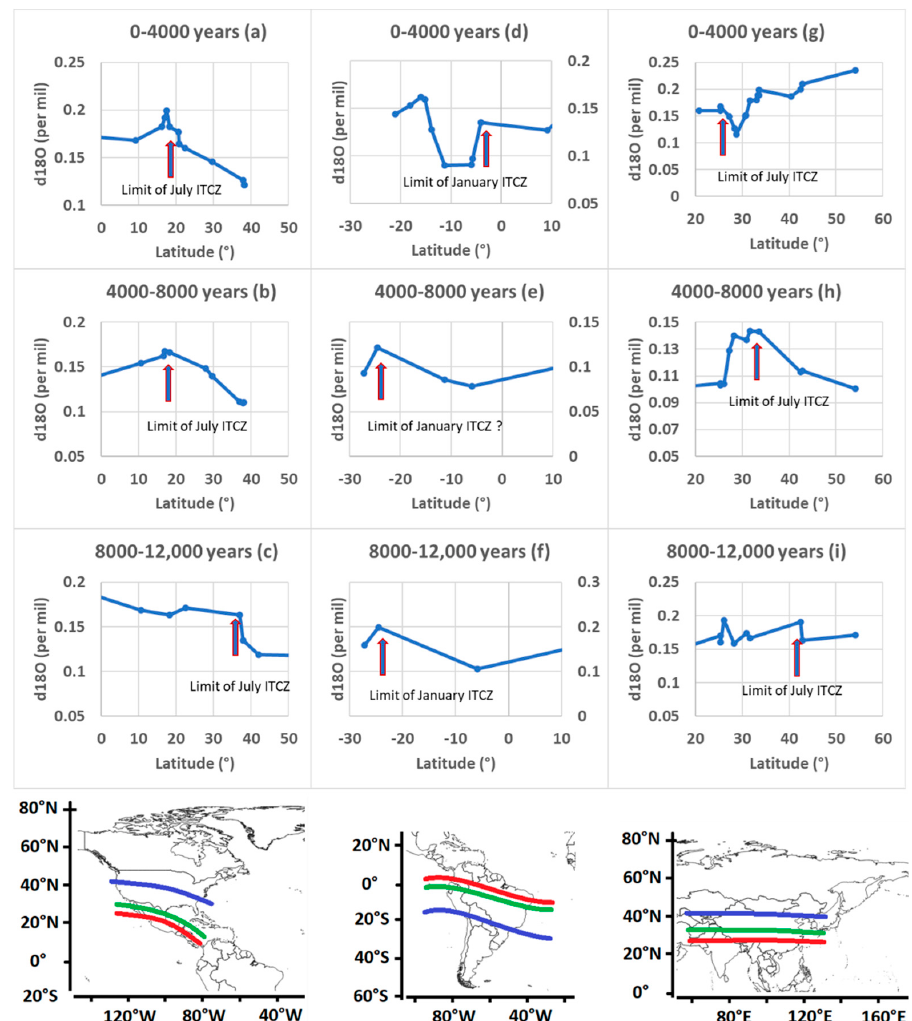
Figure 10. Graphs represent the amplitude of rainfall oscillation ( δ 18 O per mil) according to the latitudes of deduced location of summer ITCZ. The limit is located where the amplitude drops when following it from the equator—( a – c ) refer to North America, ( d – f ) to the South America. For a given latitude, all the available speleothems are considered. Subharmonic modes are n 3 ( T 3 = 256 years) in ( a – c ), n 2 ( T 2 = 128 years) in ( d ), and n 5 ( T 5 = 1536 years) in ( e , f ). Figures ( g – i ) refer to Asia. For a given latitude, the speleothems included in the band (66 ◦ E, 124 ◦ E) are considered. Subharmonic modes are n 3 ( T 3 = 256 years) in ( g ) and n 5 ( T 5 = 1536 years) in ( h , i ). The maps below the graphics represent the migration of summer ITCZ during the Holocene (in blue, green, and red from the beginning of the Holocene to the end).